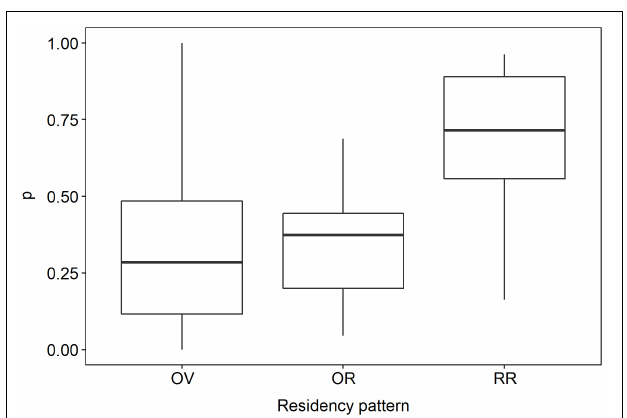
FIGURE 5 | Catchability of the bottlenose dolphin ( T. truncatus ) in the coastal waters off Alvarado Lagoon System according to their residency pattern. OV = occasional visitors ( n = 46), OR = occasional residents ( n = 45), RR = regular residents ( n =